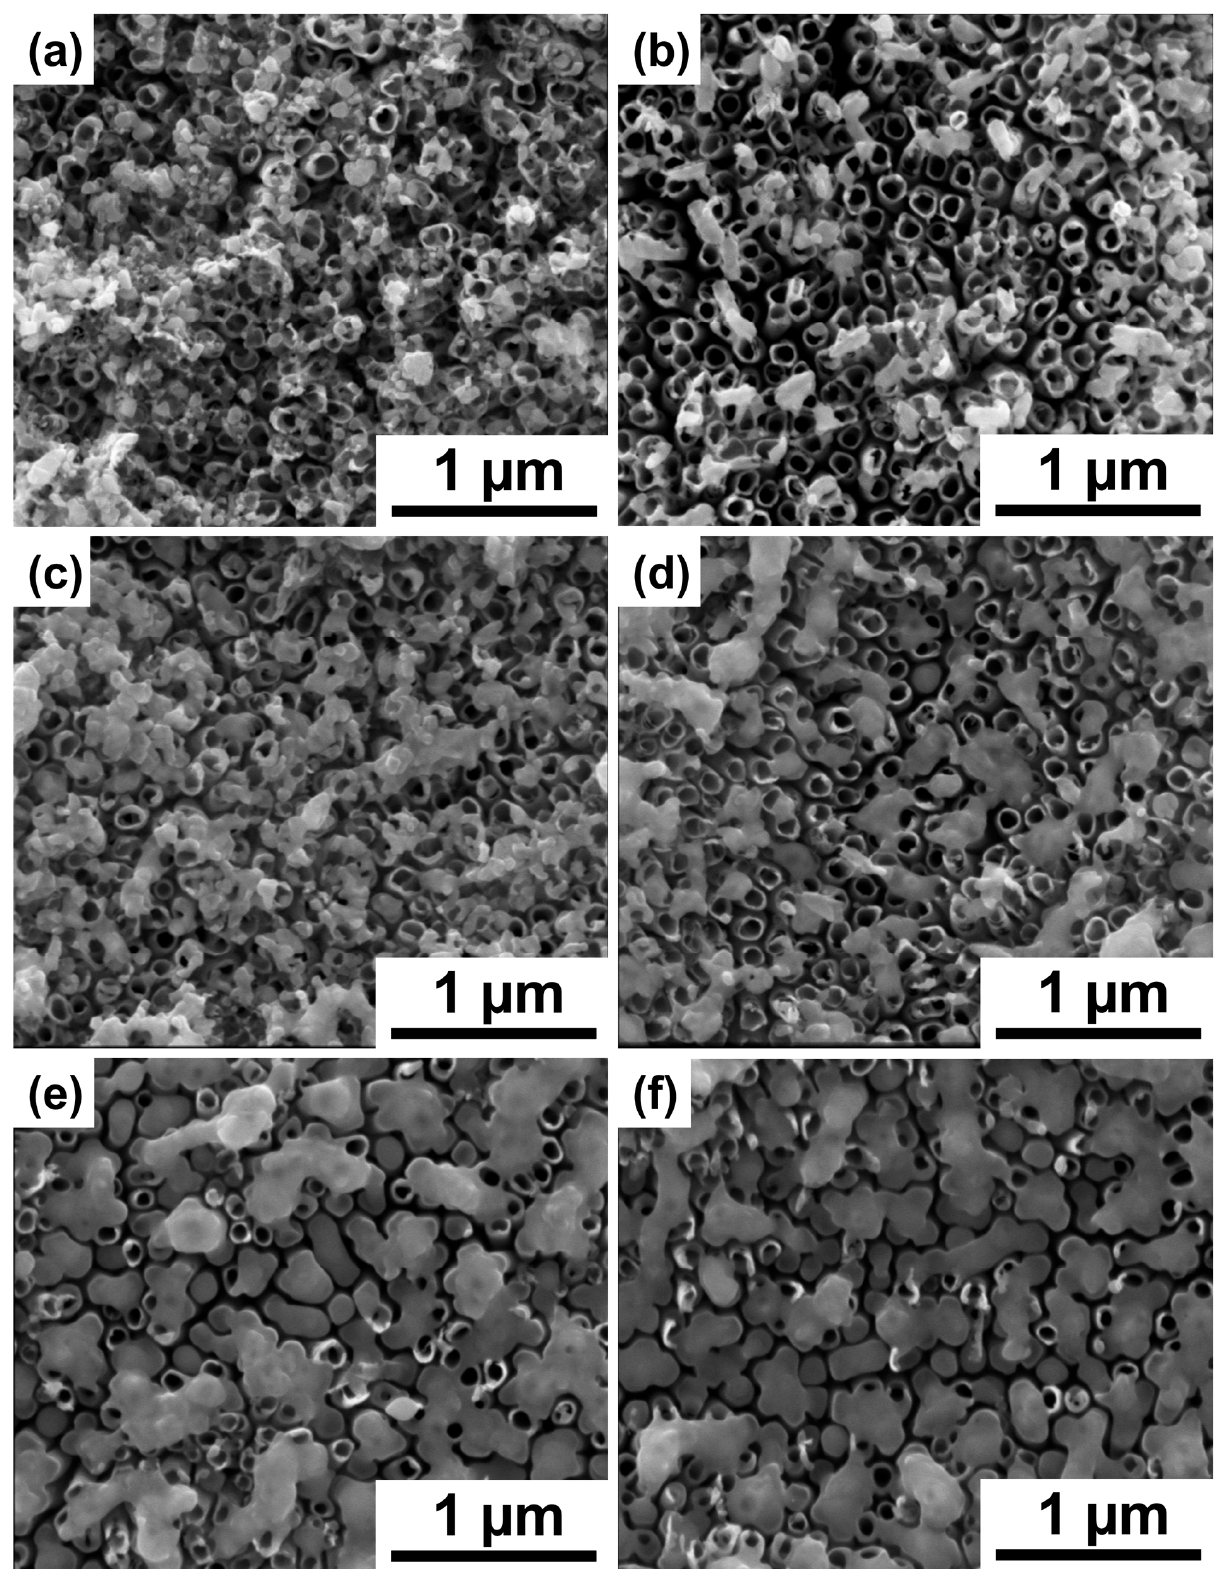
Figure 1. SEM images of the TiO 2 nanotubes decorated with chromium oxides ( a ) before and ( b – f ) after laser treatment with ( b ) 10 mJ cm − 2 , ( c ) 20 mJ cm − 2 , ( d ) 30 mJ cm − 2 , ( e ) 40 mJ cm − 2 , and ( f ) 50 mJ cm − 2 fl uence.